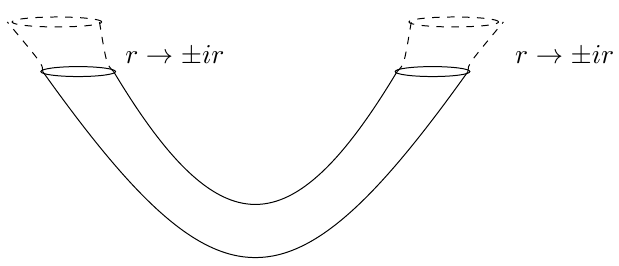
Figure 2 . dS double trumpet from AdS double